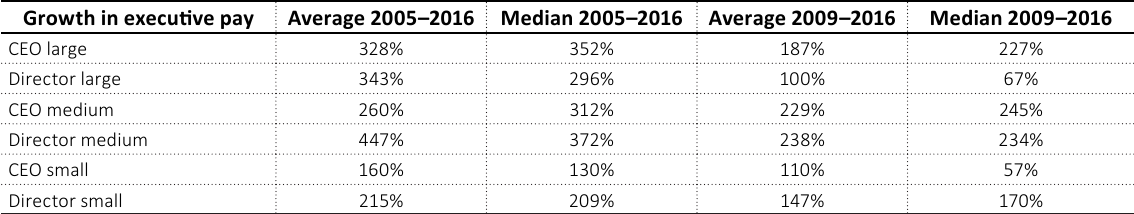
Table 1. Executive pay growth